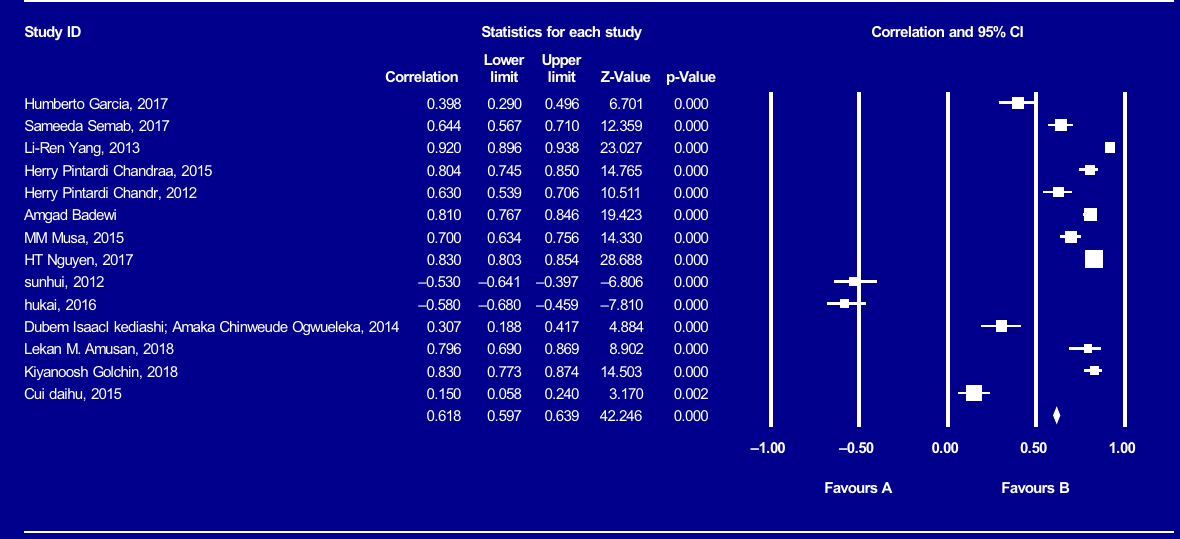
Figure A2. Results of meta-analysis